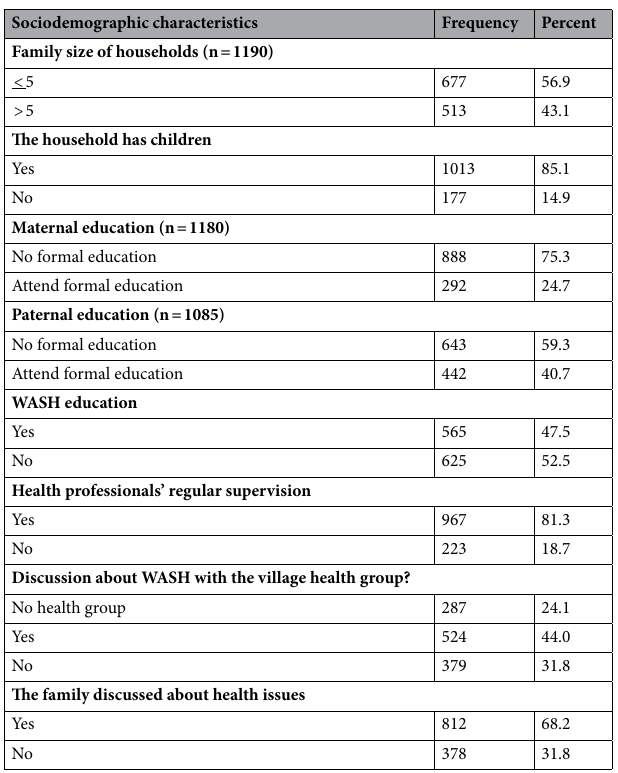
Table 1. Sociodemographic characteristics of households (n = 1190) in a rural setting of northwest Ethiopia, May 2016.